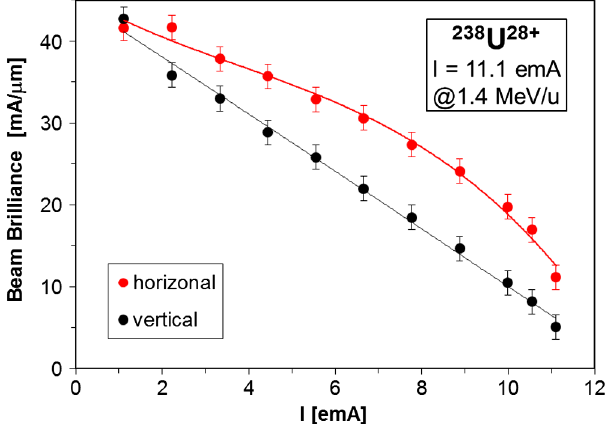
FIG. 4. Horizontal and vertical brilliance (at 1 . 4 MeV = u) for uranium beam on H 2 -target (maximum U 28 þ beam pulse current: 11.1 emA).